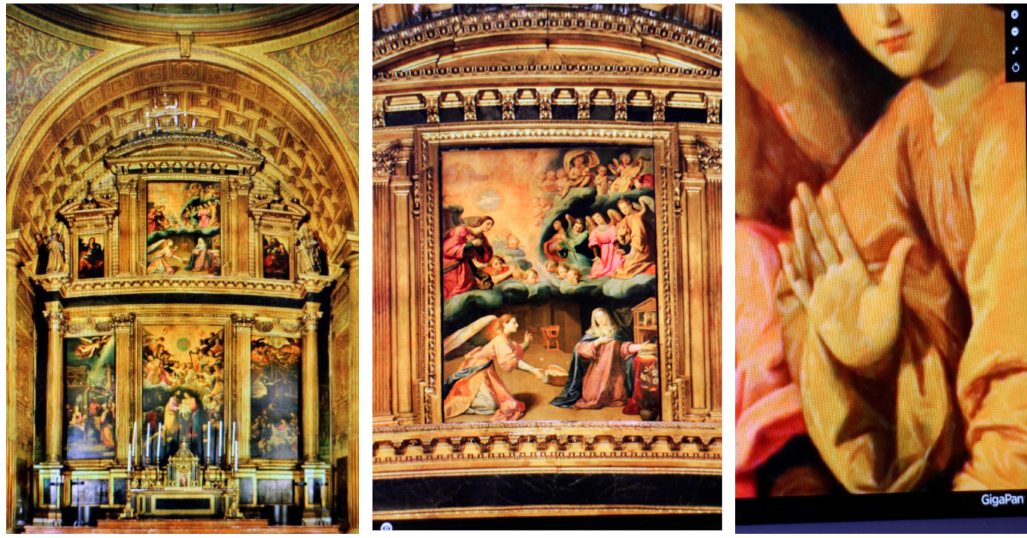
Figure 5. Gigapixel image of the Church of the